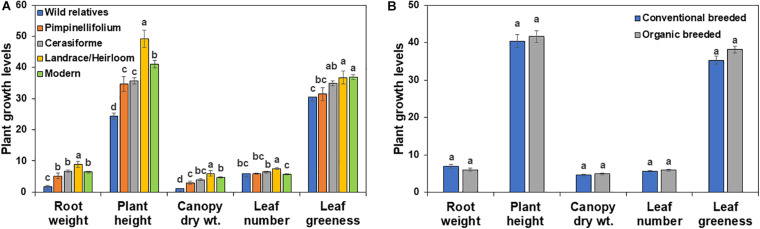
Effects of tomato (A) domestication and (B) breeding conditions on basal plant growth and development in diverse tomato groups (see Table 1). For each tomato genotypes six biological replicates were included per treatment. Root weight, plant height, canopy dry weight, leaf number and leaf greenness are presented in g, cm, g, count and Spad meter value, respectively. Columns labeled by a different letter are significantly different at P ≤ 0.05 according to Tukey-Kramer HSD test within each individual growth parameter.